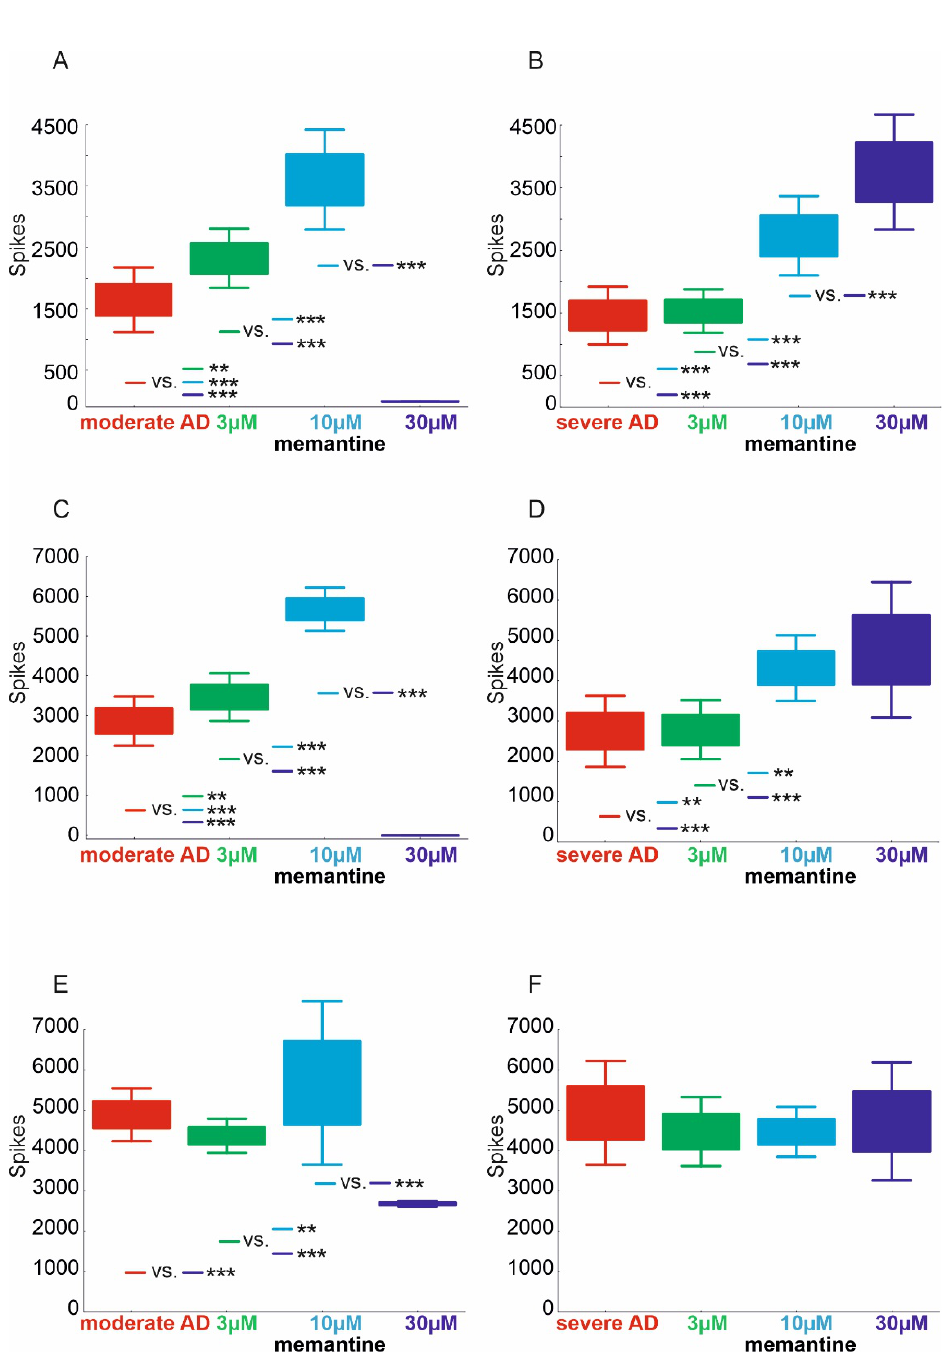
Figure 1. Comparison of number of spikes in virtual therapy of memantine treatment at three concentrations: 3 µM, 10 µM and 30 µM . ( A ) CA1 region moderate AD, ( B ) CA1 region severe AD, ( C ) CA3 region moderate AD, ( D ) CA3 region severe AD, ( E ) DG region moderate AD, ( F ) DG region severe AD (** p < 0.01, *** p < 0.001) .